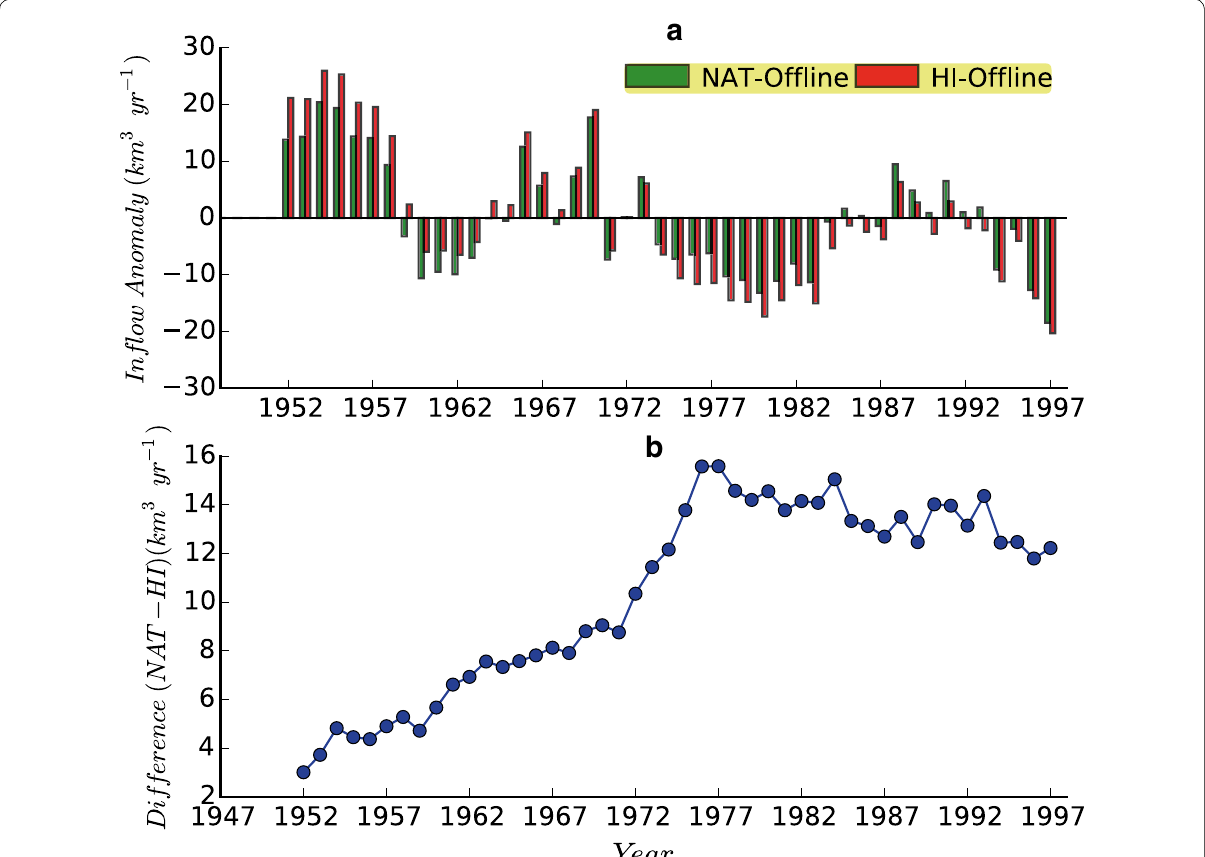
Fig. 3 Anomaly of the inflow to the Aral Sea from two major river basins simulated by NAT-Offline and HI-Offline experiments ( a ), and the differ- ence (NAT-Offline–HI-Offline) in annual flow volume between the results of two simulations ( b ). Results are shown as five year running mean. Note that the NAT-Offline and HI-Offline results in ( a ) have different climatological mean and that the results in ( b ) are the difference of the absolute flow